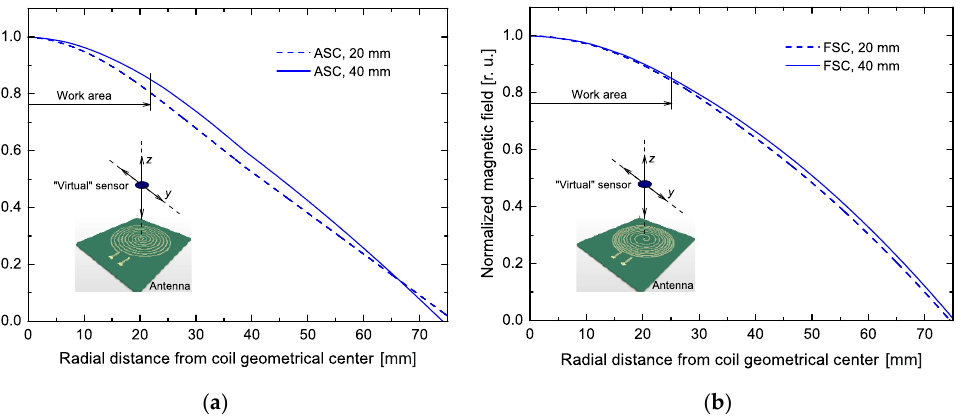
Figure 6. Simulation of magnetic-field decay at the frequency 4.645 MHz: ( a ) at distances of 20 mm and 40 mm from the Archimedean spiral coil; ( b ) at distances of 20 mm and 40 mm from the Fermat spiral coil. Working areas are shown at distance of 40 mm.